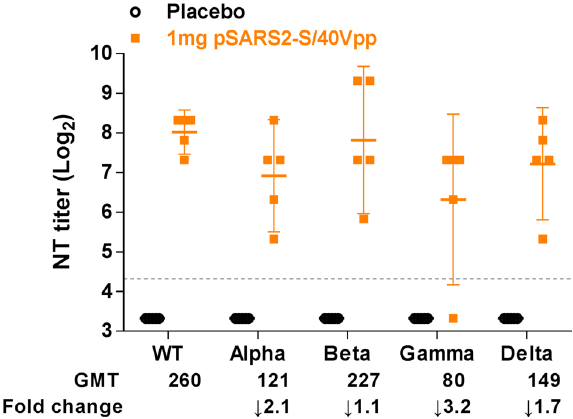
Fig. 7 Neutralization activity of the pSARS2-S DNA vaccine against SARS-CoV-2 variants in the repeated-dose toxicity study. Male SD rats ( n = 5 per group) were intramuscularly immunized three times at a 2-week interval with placebo and 1 mg of pSARS2-S DNA, followed by electrostimulation using an electroacupuncture machine (40 Vpp and 120 Hz for 5 s). Serum samples obtained at week 9 after the fi rst immunization were used to evaluate the neutralizing activity against SARS-CoV-2 variants (Wuhan (WT), Alpha, Beta, Gamma, Delta) using neutralization assay. The dashed line indicates the initial fold dilution of serum samples. The neutralizing geometric mean titers (GMT) and the GMT fold change over WT strain are shown. Neutralization titers are expressed as the geometric mean with a 95% con fi dence interval.